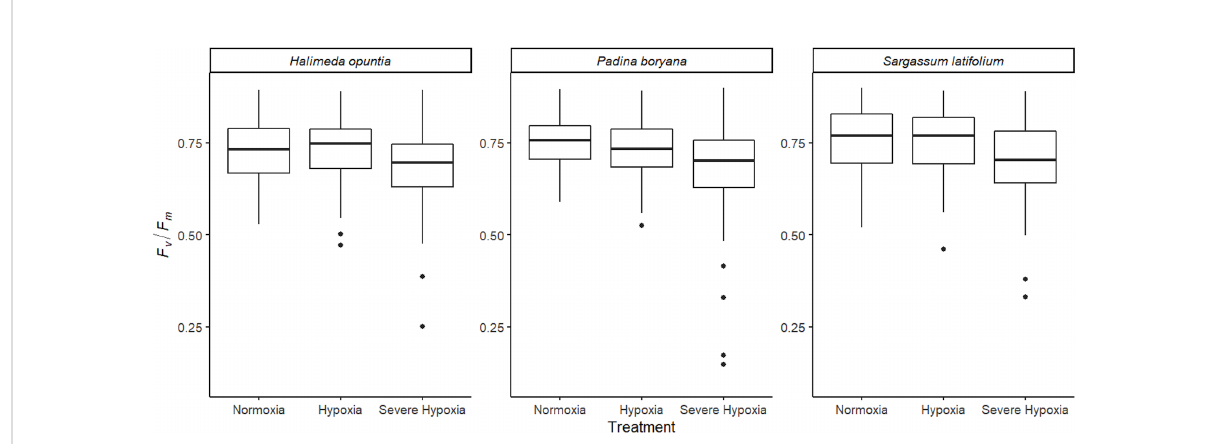
FIGURE 3 Average photochemical ef fi ciency ( Fv/Fm ) for the different species tested Halimeda opuntia , Padina boryana , and Sargassum latifolium across the different experimental treatments. Figure represents all photochemical ef fi ciency (PAM) measurements that were taken every hour during the entire duration of the experiments of 12 hours combined (at least 130 observations per treatment for each species). Whiskers represent standard error, and the black line is the